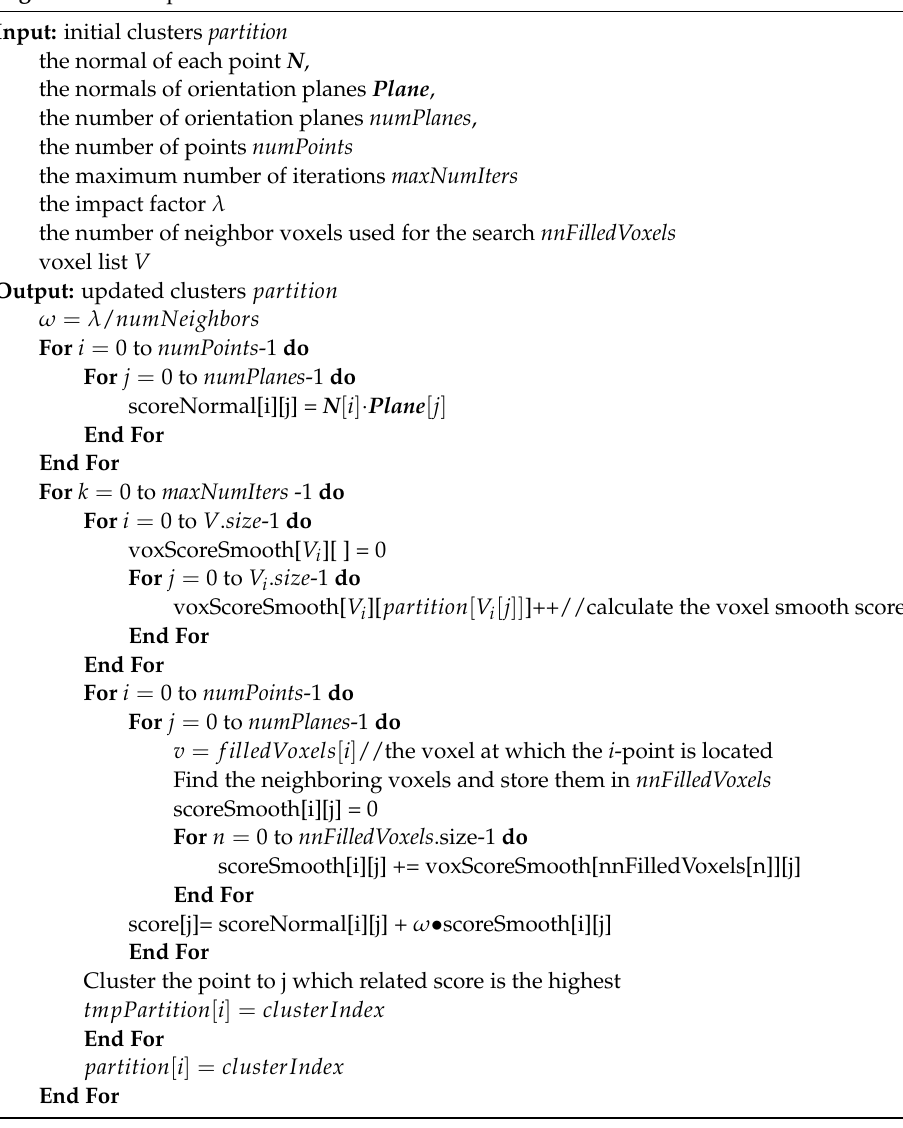
Algorithm 2 The pseudo-code of